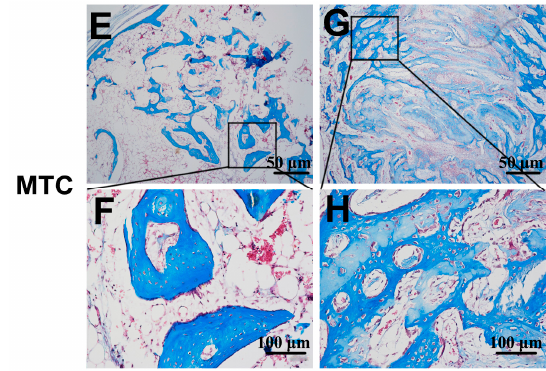
Figure 4. Histological examination of newly formed bone tissue. H&E staining: ( A , B ) In the control group, fewer newly formed island-like bone tissue structures were observed, and the neo-bone and cartilage-like tissues were sparse and unevenly distributed; ( C , D ) In contrast, in the composite constructs, a large number of interconnected ossified trabeculae and woven bone structures were observed in the peripheral regions of the constructs and large amounts of cartilage-like tissue were also observed in the central regions of the composite constructs. In addition, osteoblasts were observed in the neo-mineralized tissue and osteocytes were observed embedded in the dense matrix. On Masson’s trichrome (MTC) staining, the control group ( E , F ) also showed less osteogenesis than the composite group ( G , H ). ( A , B , E , F ) Low-magnification, 40×; ( C , D , G , H ) high-magnification, 200×.